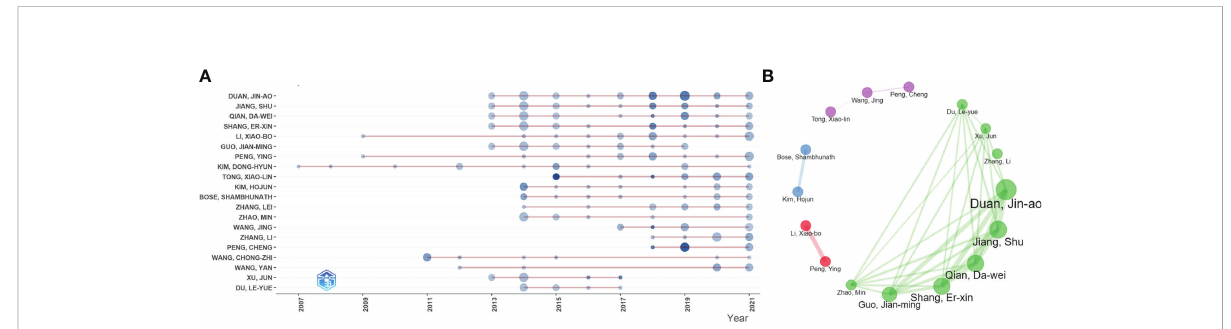
FIGURE 2 (A) The top 20 authors ’ annual publications over time in TCM/GM (the size of the circle represents the number of publications, and the larger the circle, the more the number of publications; the depth of the circle represents the average annual citation, and the darker the color, the more citations). (B) The top 20 authors ’ co-authorship network (remove isolated nodes) in TCM/GM (each node represents an author, the size of the node represents the number of published articles, the line represents the collaboration network between authors, and the thickness of the line represents the strength of collaboration).